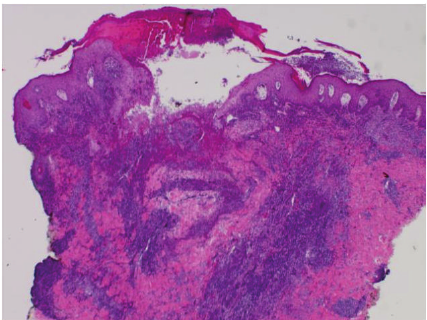
Figure 3: Low-power H&E: ulcerated papule with mixed superficial and also deep inflammatory infiltrate.